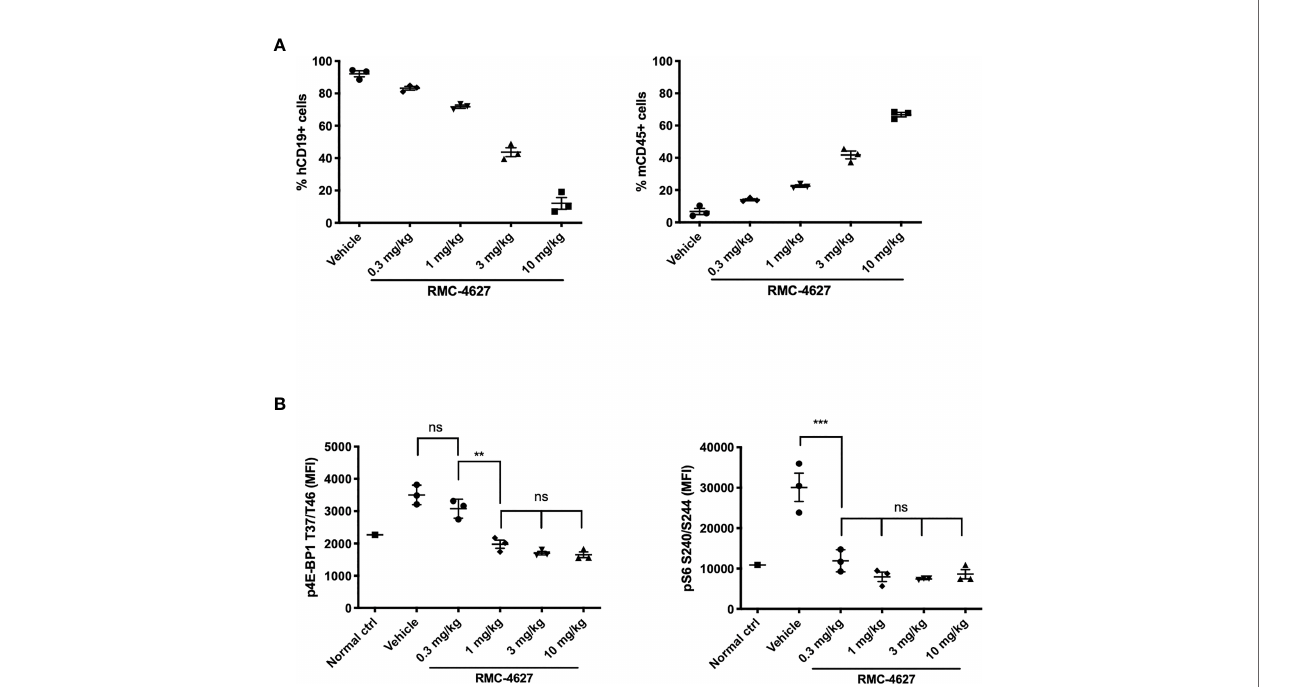
FIGURE 4 | RMC-4627 reduces leukemic burden and suppresses phosphorylation of 4E-BP1 and S6 in a Ph+ B-ALL xenograft model. (A) Percentage of human leukemia (% hCD19+ cells) (left) and percentage of mouse lymphocytes (% mCD45+ cells) in bone marrow of SUP-B15 xenografts dosed with RMC-4627 (ip qw) for 4 weeks. Data are the mean percentages of each group (n=3; center line) with error bars representing SEM. (B) Levels of p4EBP1 T37/T46 and pS6 S240/S244 determined in bone marrow of SUP-B15 xenografts (live cell population) 4-5 hours after the fi nal dose of a repeat dosing schedule with RMC-4627, and compared to a healthy age-matched control NSG mouse (normal ctrl). Data are the mean signal of each group (n=3; center line) with error bars representing SD. Statistical test: ordinary one-way analysis of variance (ANOVA) with post-hoc Tukey ’ s multiple comparison test (See Supplementary Table 2 for exact P values and corresponding ns, **, and ***